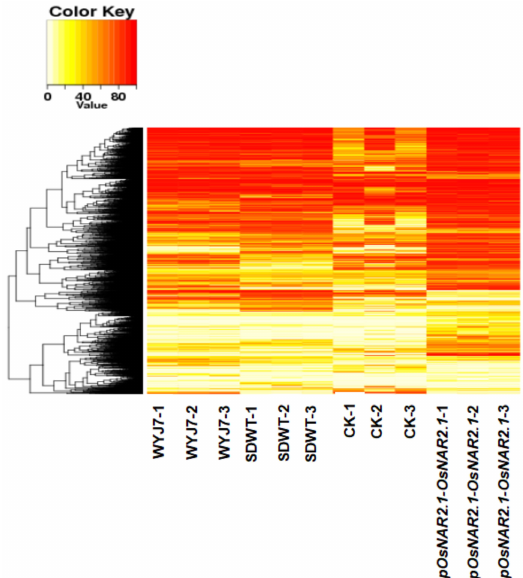
Figure 3. Heatmap for DMRs methylation level cluster. Heatmap representation of hierarchical clustering based on CG methylation levels within DMRs. Rows represent all DMRs identified and columns represent the